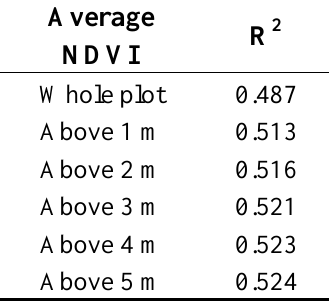
Table 2. Plot percent mortality on plot average NDVI masked from 0 to 5